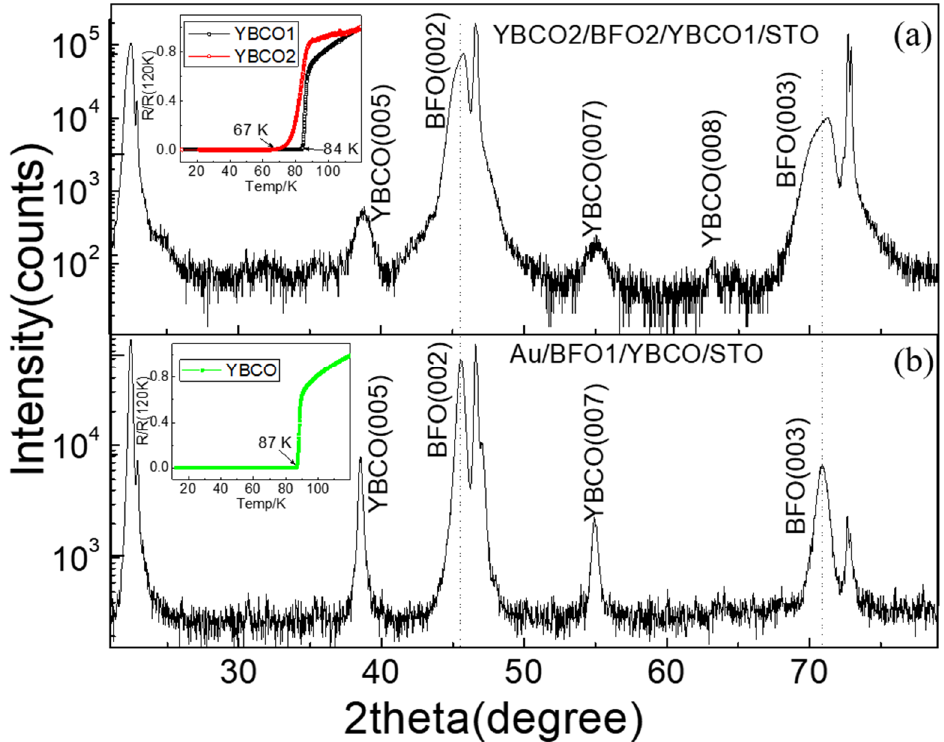
Figure 2. XRD images of the YBCO2/BFO2/YBCO1 capacitor ( a ) and the Au/BFO1/YBCO capacitor ( b ). The inset of ( a ) shows the resistive versus temperature curves of YBCO1 (black curve) and YBCO2 (red curve). The inset of ( b ) shows the resistive versus temperature curve of YBCO in the Au/BFO1/YBCO capacitor.